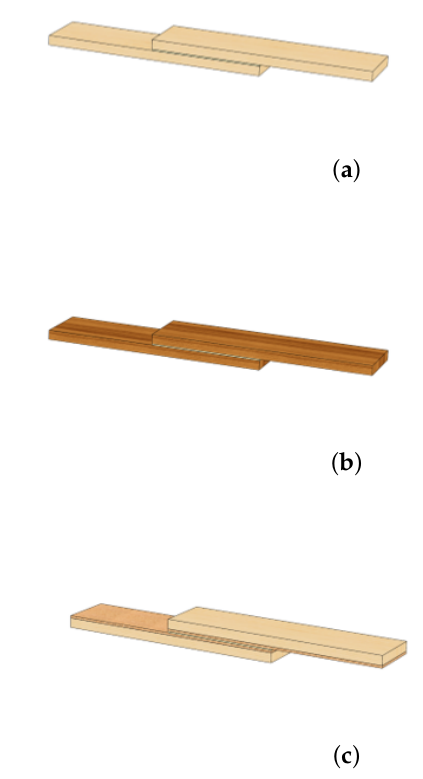
Figure 5. Illustration of the SLJs tested: ( a ) W. ( b ) DW. ( c )